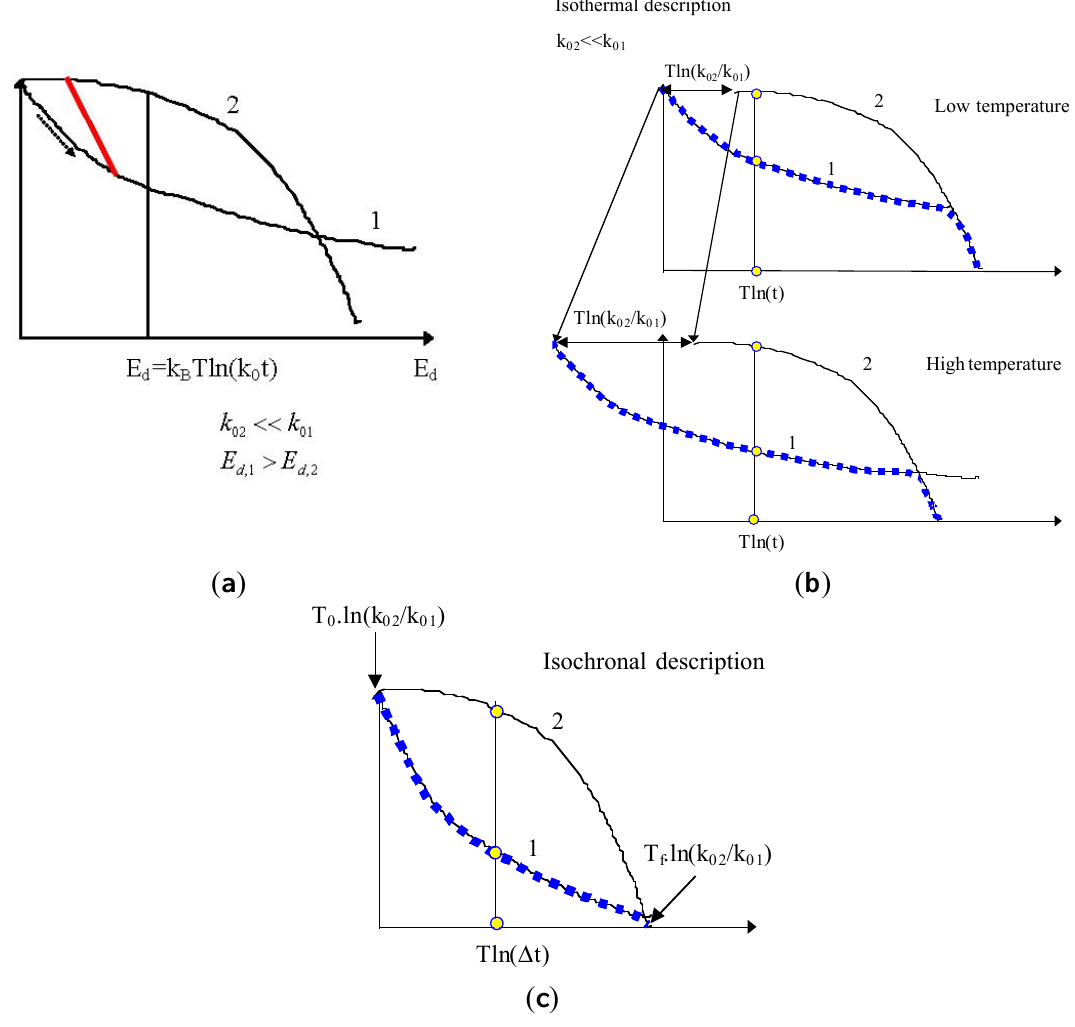
Figure 44. ( a ) Due to different k 0 , the rate of evolution along reaction 1 or 2 are not the same; ( b ) Isothermal description. The dashed line shows the evolution of the erasure; ( c ) Isochronal description. Since the shift of the master curves increases as T increases, the cross point can be not